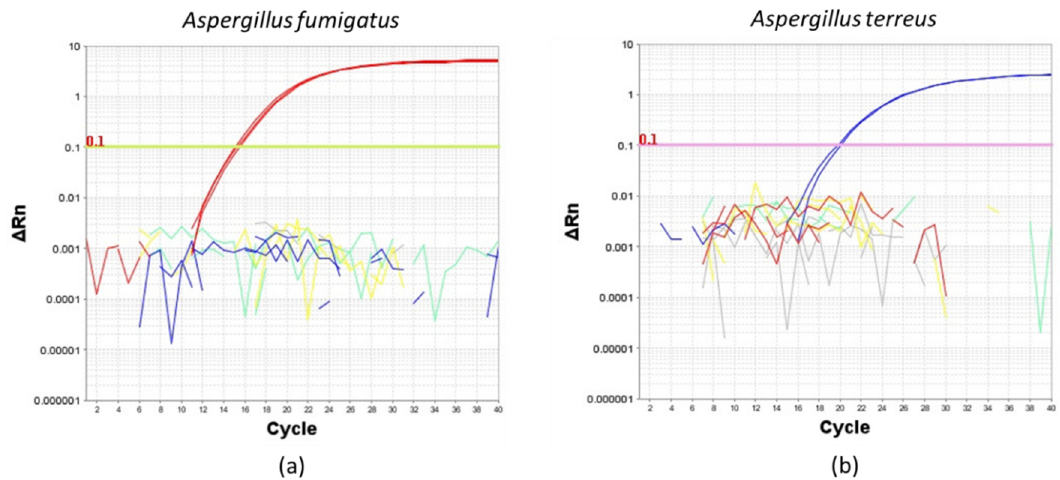
Figure 2. Amplification plots illustrating the specificity of ( a ) Aspergillus fumigatus and ( b ) Aspergillus terreus TaqMan primers and probes using a reaction mix containing 0.1 ng of extracted DNA from pure cultures of ( a ) Aspergillus fumigatus (red line), ( b ) Aspergillus terreus (blue line), Aspergillus flavus (yellow line) and Aspergillus niger (green line). No template control is indicated by gray lines. ∆ Rn: delta normalized reported value.